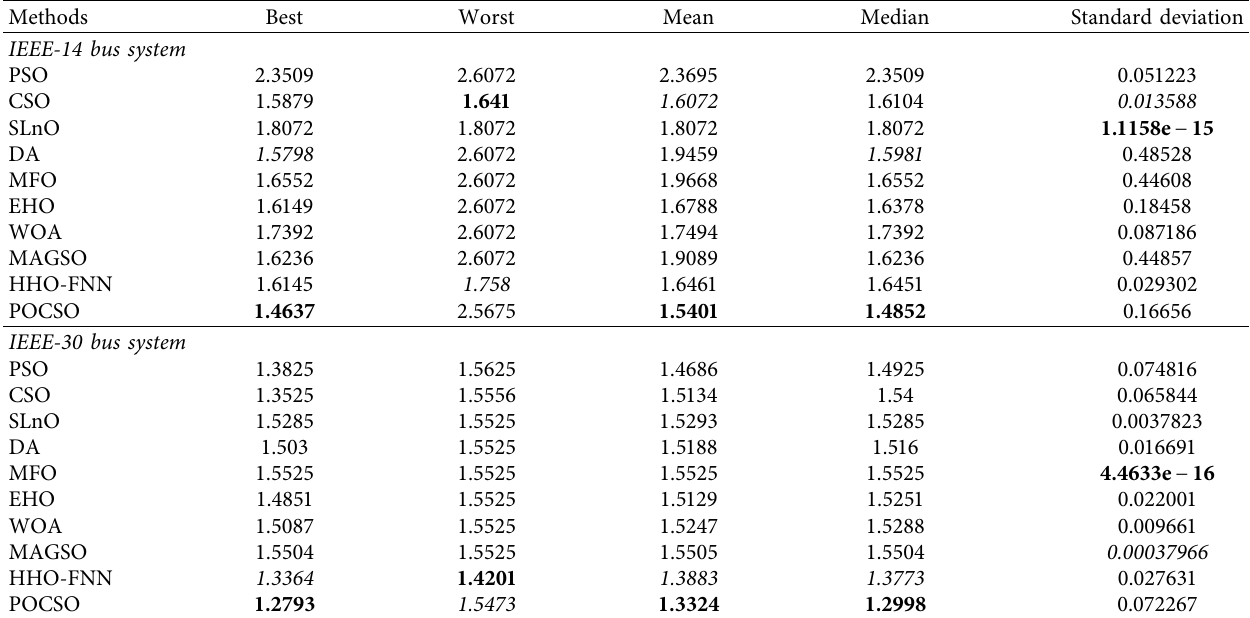
Table 10: Statistical evaluation of the proposed and conventional work for optimal power generation IEEE-14 and IEEE-30 bus systems.